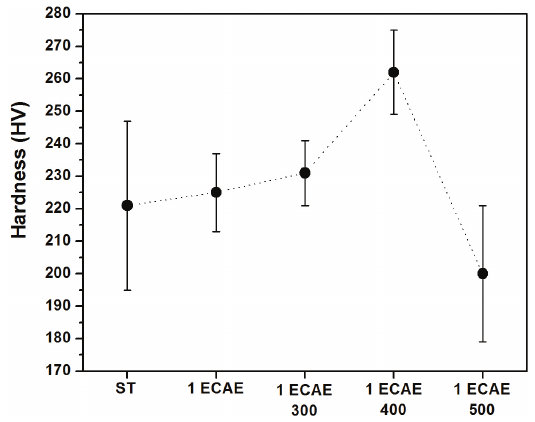
Figure 1. Hardness values of solution treated (ST), deformed (1 ECAE) and annealed samples at 300 °C/1h (1 ECAE 300), 400 °C/1h (1 ECAE 400) and 500 °C/1h (1 ECAE 500).